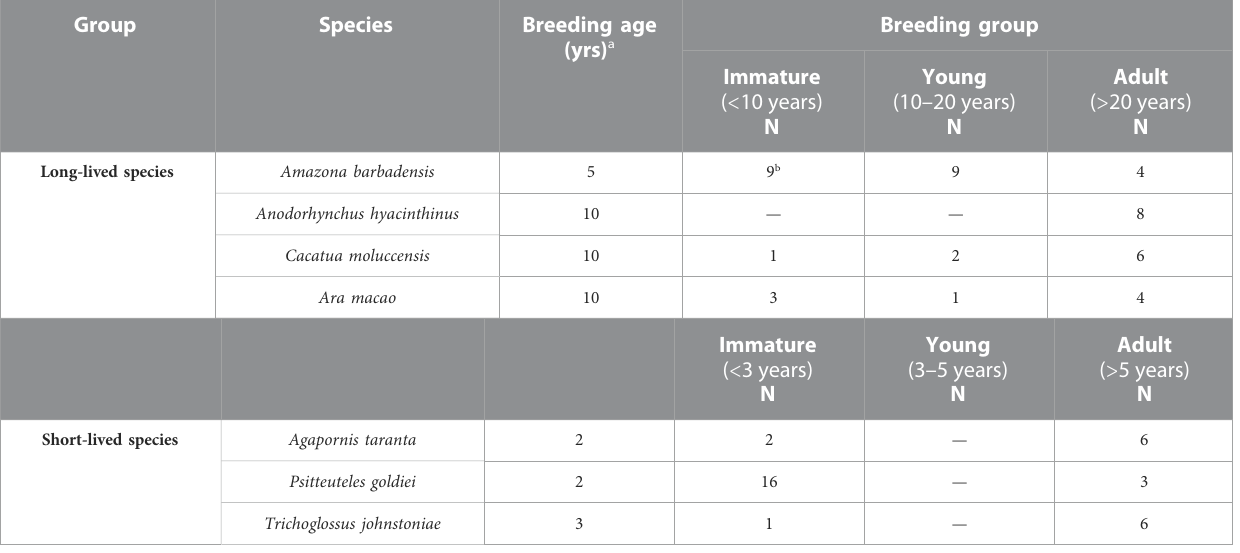
TABLE 2 Distribution of individuals in breeding groups according to the age at which they reach sexual maturity.